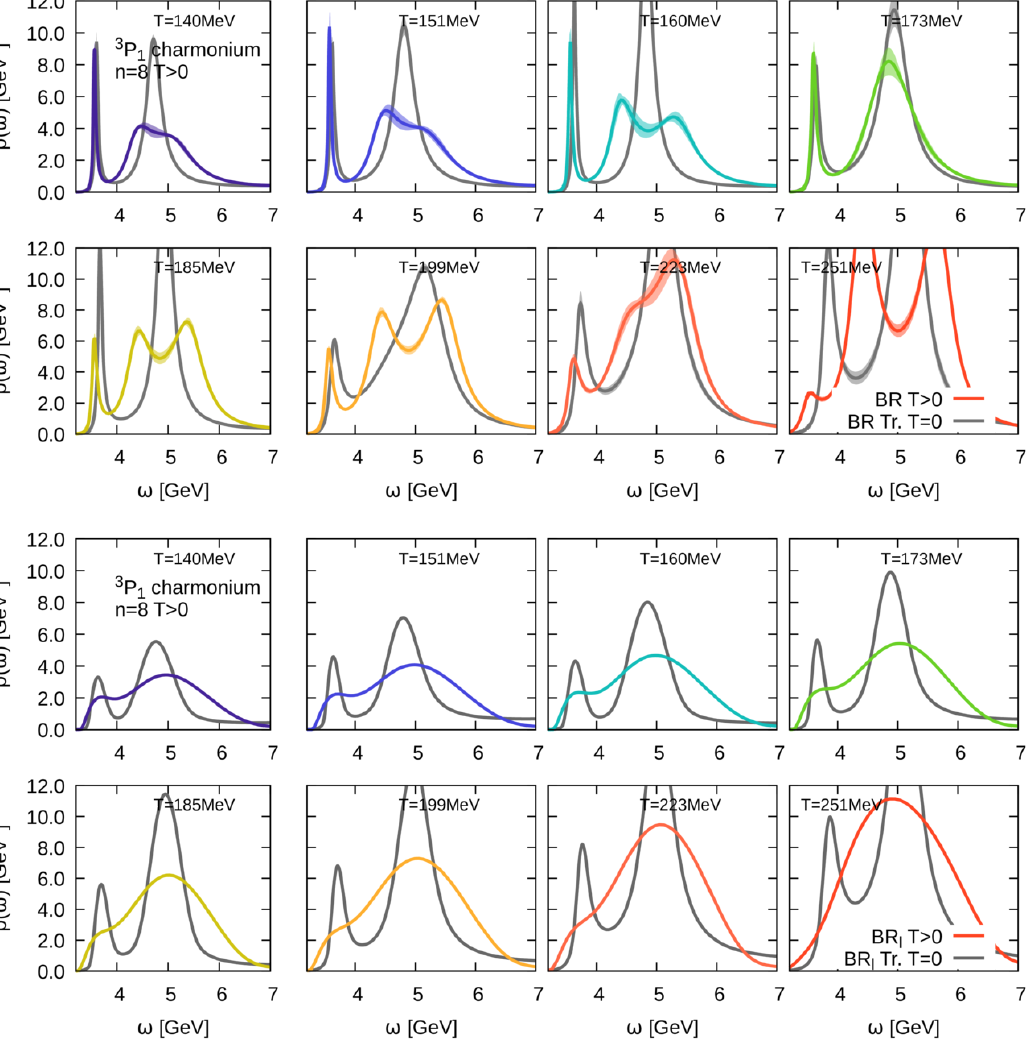
Figure 43 . Comparison of the (top) BR truncated at T = 0 and at T > 0 (bottom) the same comparison for the smooth BR method in the 3 P 1 charmonium channel. Here we have the same statistics at T = 0 and at T >